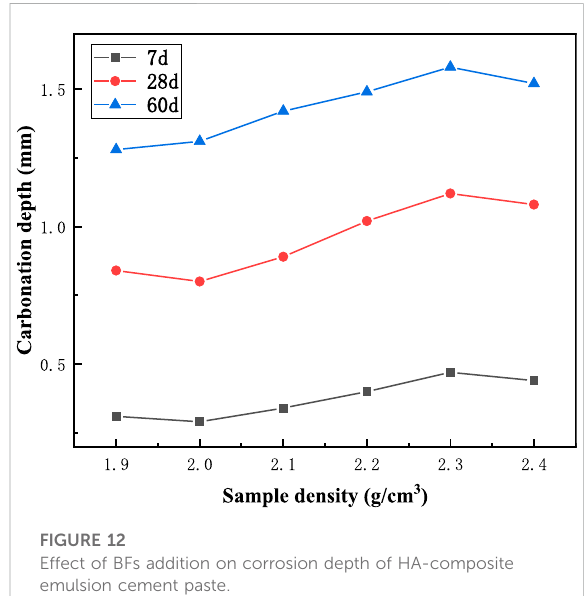
FIGURE 12 Effect of BFs addition on corrosion depth of HA-composite emulsion cement